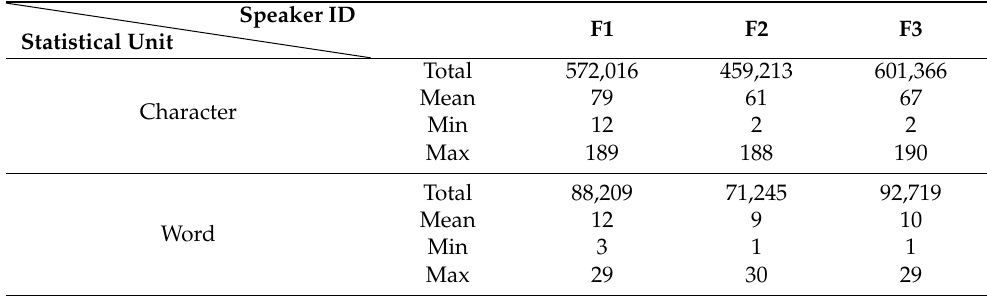
Figure 2. Word number distributions ( a – c ) and sentence duration distributions ( d – f ) for all speakers of MnTTS2. Table 1. The statistics of the MnTTS2